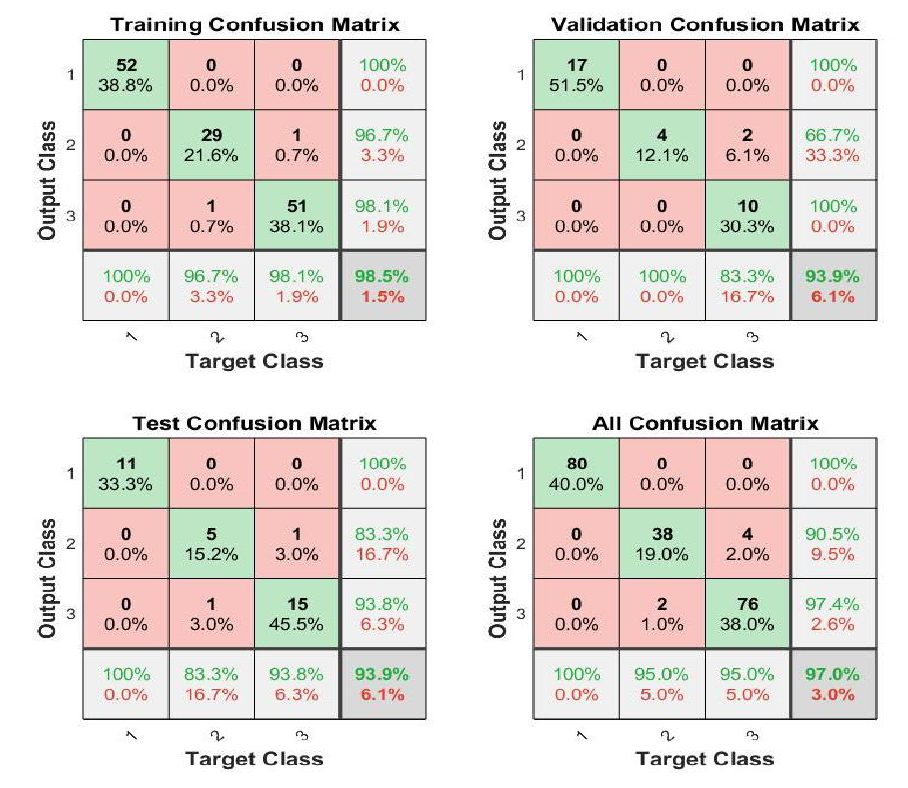
98.26%, specificity of 92.21%, and AUC of 95.03%. Regarding the PH2 dataset, the FFNN algorithm outperformed the ANN algorithm. The FFNN algorithm reached an accuracy of 97.91%, precision of 97.09%, sensitivity of 98.68%, specificity of 97.14%, and AUC of 97.89%. At the same time, the ANN algorithm achieved accuracy of 97%, precision of